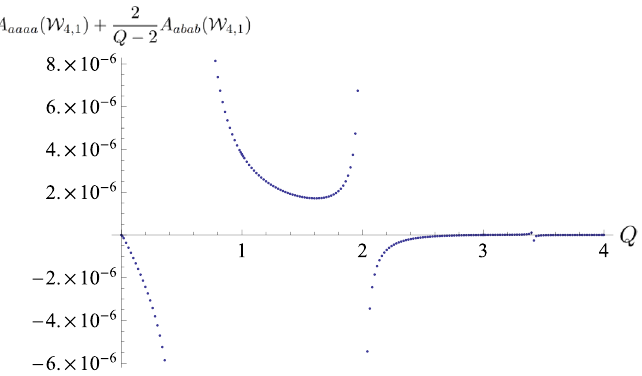
P abab (the right-hand side Q − 2